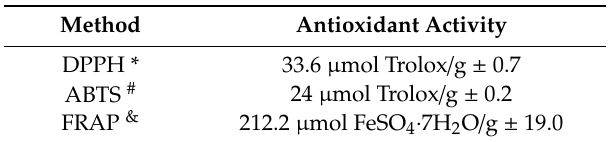
Table 2. The antioxidant activity of the microparticles produced by experimental run 6 as expressed using di ff erent methods of measurement.